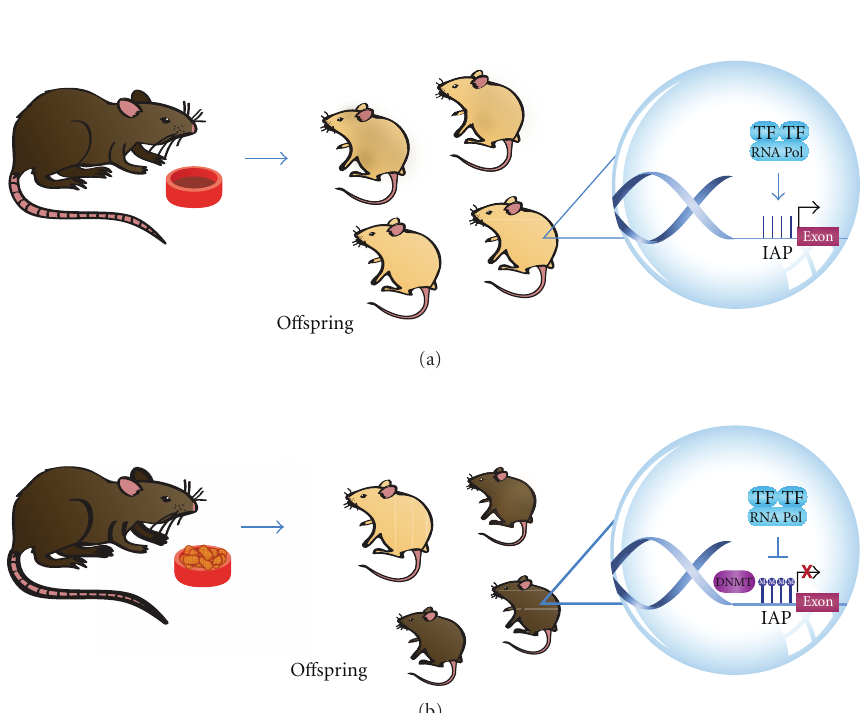
Figure 1: Epigenetic-environmental interaction. O ff spring of pregnant Agouti rodents fed with food rich in methyl donors had a di ff erent color of coat (brown, (b)) due to an increased DNA methylation status in the viable yellow allele ( A vy allele), in comparison to o ff spring of pregnant rodents fed a normal diet (yellow or mottle, (a)). Intracisternal A Particle (IAP), Transcription Factor (TF), RNA Polymerase (RNA Pol), Methylated Cytosine (M).